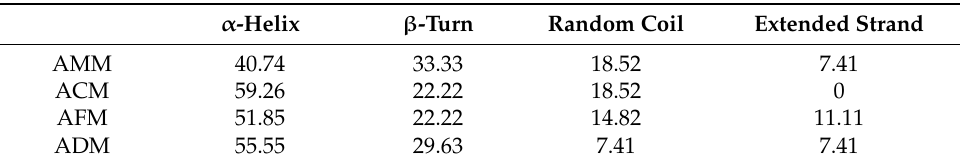
Table 3. Representation of the melittin secondary structure from honey bees predicted via SOPMA (in percentages).